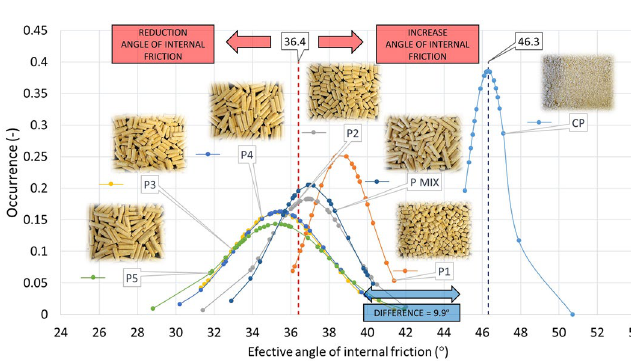
Figure 12. Effective angle of internal friction pellets P1–P5, PMIX and CP.